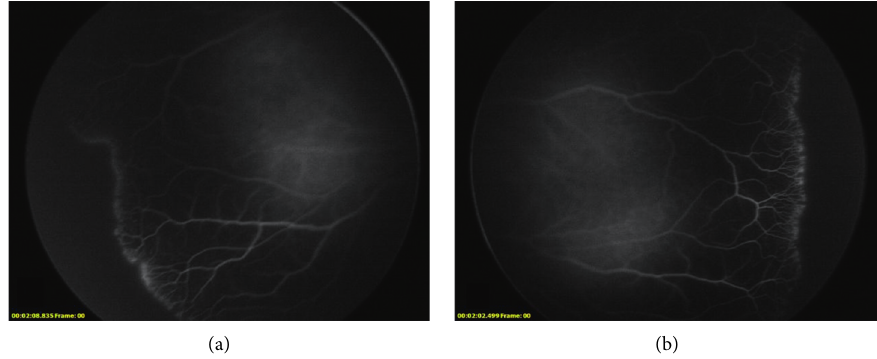
Figure 1: Fluorescein angiography (FA) of case 1. (a) Right eye. (b) Left eye. Both eyes were zone II stage 1 without plus disease. Irregular sprouts of vascularisation at the vascular/avascular junction, distinct pruning of vessels, and pinpoint areas of hyperfluorescence were observed.